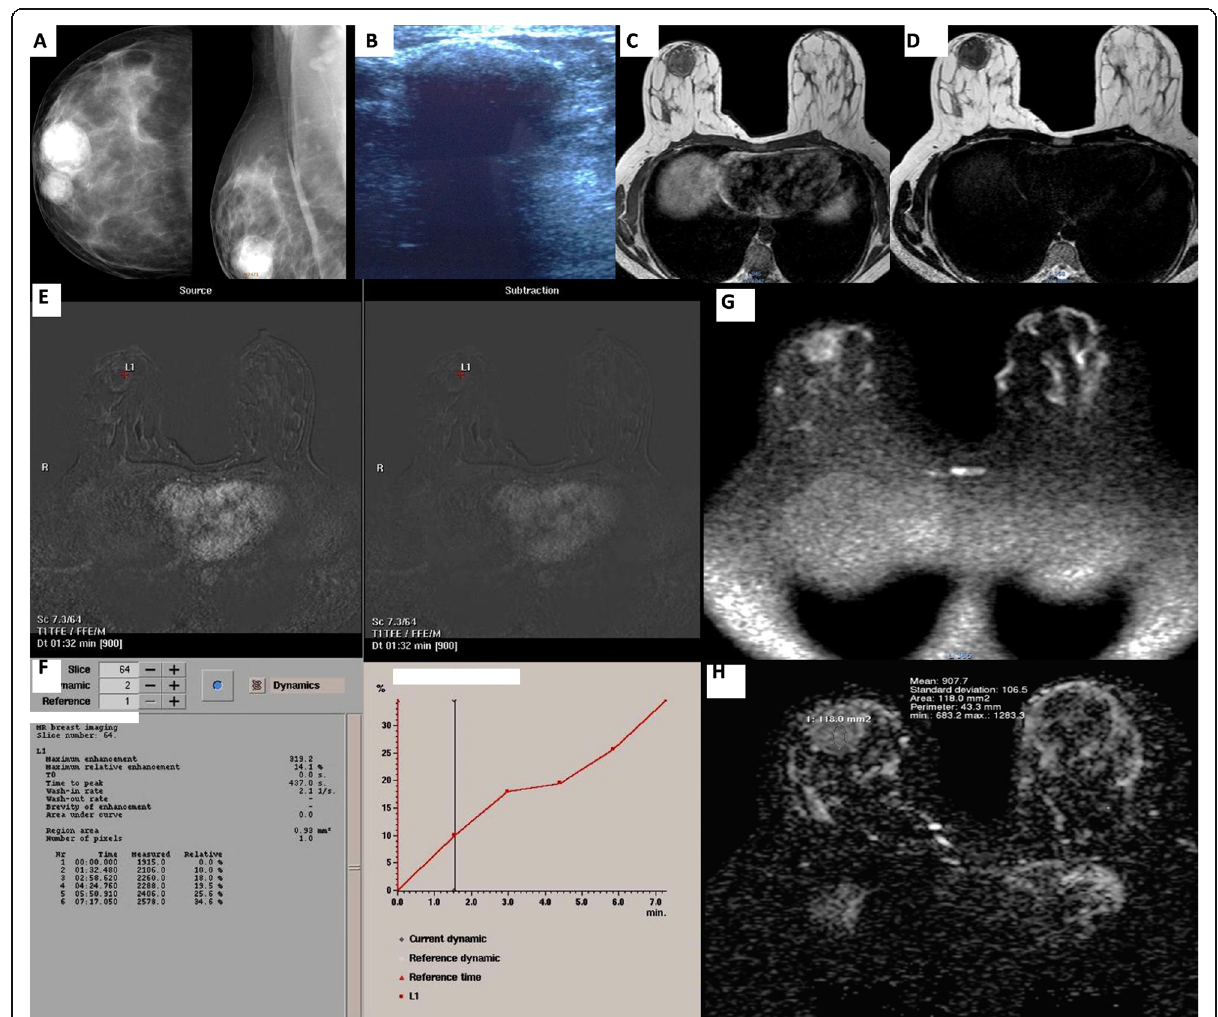
Fig. 5 A 31-year-old female presented with right breast lump and pain. Mammography ( A ) showed two large retroareolar well-defined lesions of mixed densities predominantly hyperdense, and ultrasound (B) showed right retroareolar large well-defined mass of mixed echogenicity predominantly hypoechoic with posterior acoustic shadowing. Sonomammography revealed BIRADS 3. MRI axial images showed right large well- defined retroareolar mass showing heterogeneous signal on T1 ( C ) with elements of hyperintensity and intermediate signal on T2 WIs ( D ). MRI axial dynamic THRIVE sequence and subtraction image ( E ) showed right retroareolar well-defined mass with marginal contrast uptake. Time/signal intensity analysis ( F ) of ROI showed continuous rising curve pattern (type I) with SI % of 35%. Diffusion sequence b 850 ( G ) and post-processing ADC map ( H ) showed mixed signal intensity with foci of restricted diffusion in the right retroareolar mass. ADC value for ROI was 0.9 × 10 − 3 mm 2